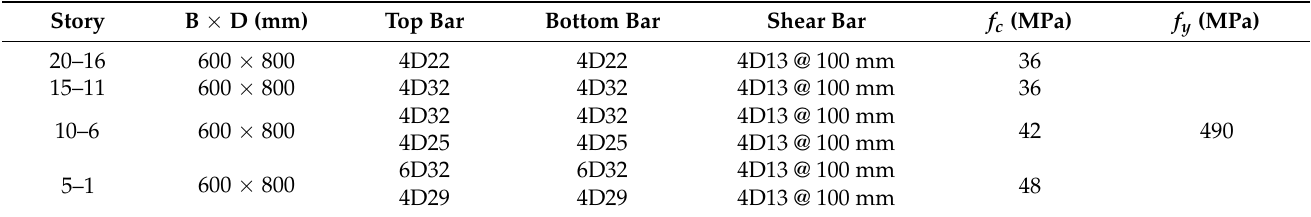
Table 2. Structural parameters of RC